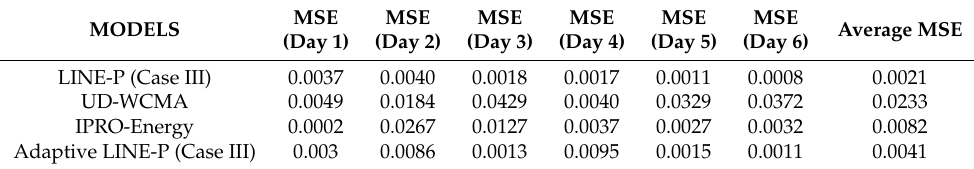
Table 13. Error comparison of the energy prediction models in terms of MSE for the solar energy profile.